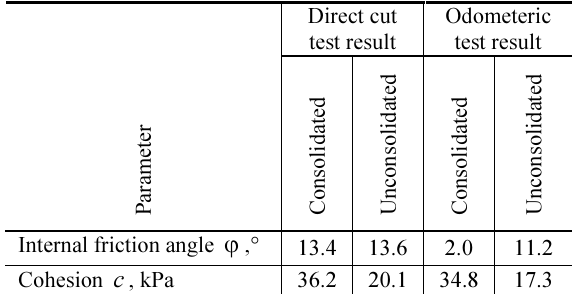
Table 3. Results of clay strength testing in unconsolidated- undrained